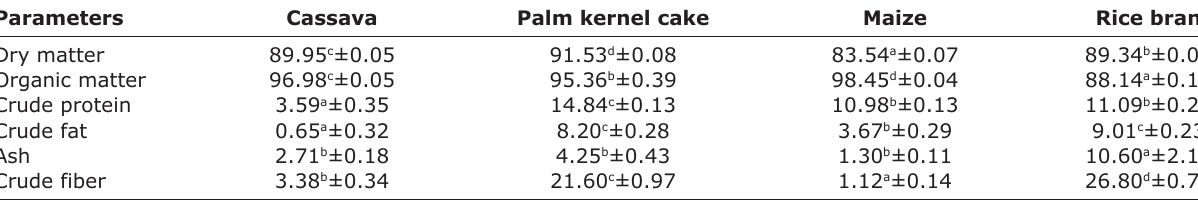
Table-2: Proximate analysis of concentrates (% of dry matter).